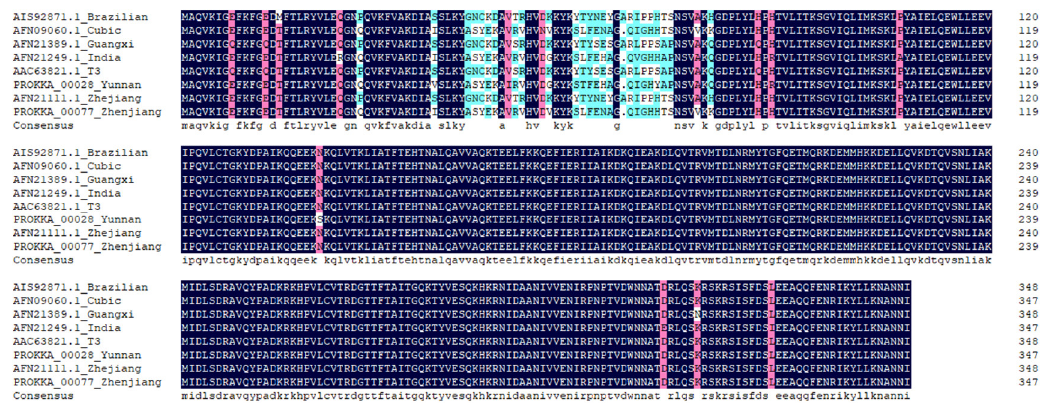
Figure 4. Alignment of amino acid sequences of BRO-D protein from different BmNPV strains. The bro-d gene was chosen for the evolutionary analysis of the two BmNPVs. Using Plutella xylostella multiple nucleopolyhedrovirus (PxMNPV) as the exogenous reference, the phylogenetic tree was plotted using the MEGA 7.1 software (https://megasoftware.net/ accessed on 26 September 2021). The results are shown in Figure 5. The eight BmNPV strains were divided into two clades. Both BmNPV ZJ (Zhenjiang) and BmNPV YN (Yunnan) were grouped in clade I, and BmNPV ZJ was closer to the Cubic strain (IQ991009) while BmNPV YN was closer to the India strain (JQ991010). These finding are similar to those reported by Tang et al. [12].